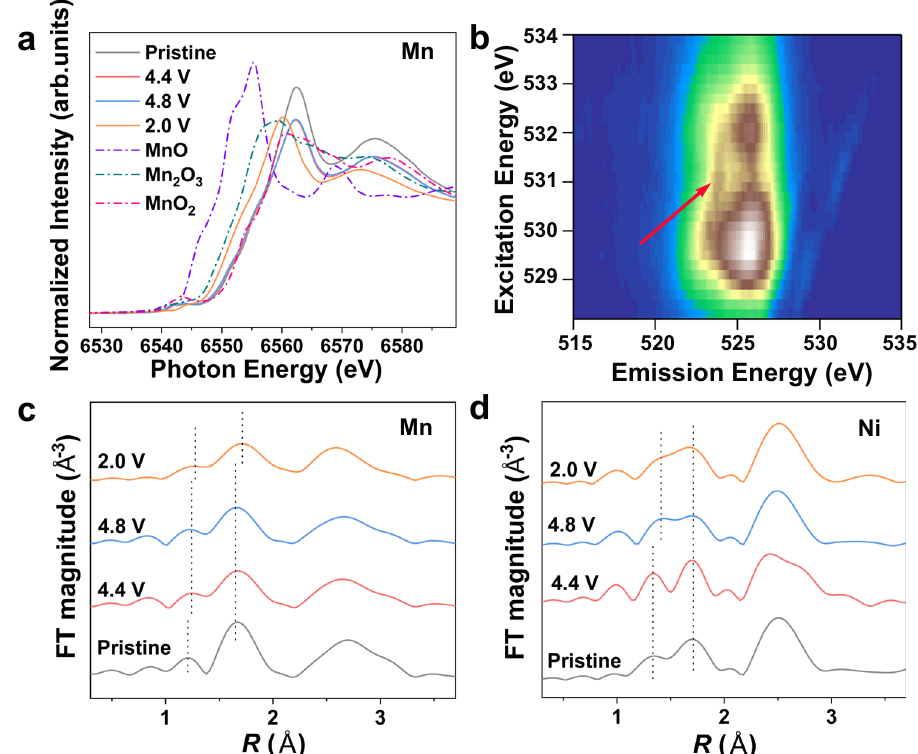
Fig.6|ExsituX-raycharacterizationsofLi 1.46 Ni 0.32 Mn 1.2 O 4 – x -basedelectrodes. a Normalized ex situ Mn K-edge XANES spectra obtained from CD-LNMO electro- des at different voltages during the fi rst cycle. The Mn K-edge XANES spectra of MnO, Mn 2 O 3 , and MnO 2 are shown for reference. The 4.4V and 4.8V curves are charged states, and the 2.0V curve is the discharge state. The cells are cycled within 2.0 – 4.8V at a speci fi c current of 100mAg − 1 under 25±5°C. b O-K-edge